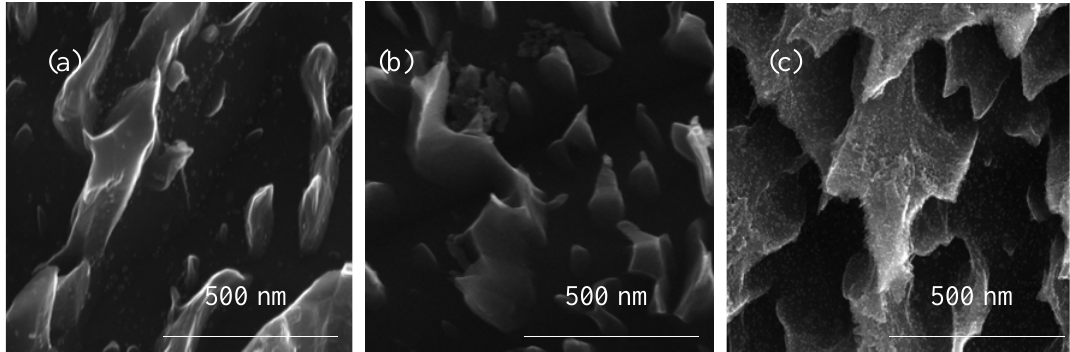
Figure 4. SEM images of PTN ( a ); TNTE03 ( b ); and TNTE2 ( c ) made in the form of side view.